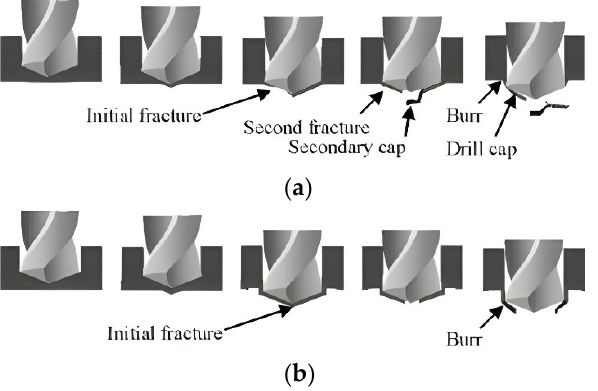
Figure 5. Mechanism of burr formation in drilling process: ( a ) uniform burr and ( b ) crown burr